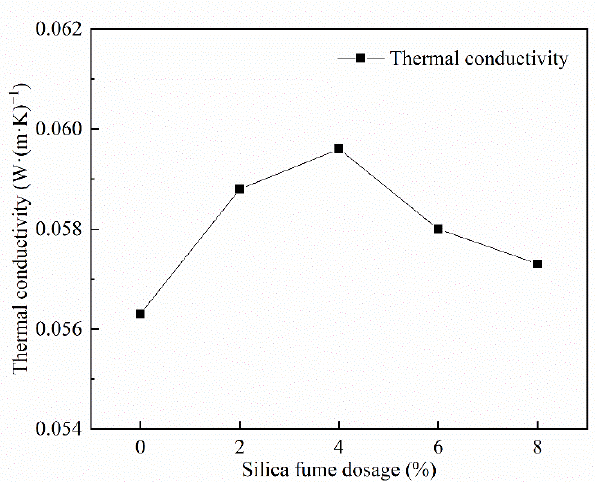
Figure 8. Influence of silica fume dosing on thermal conductivity.